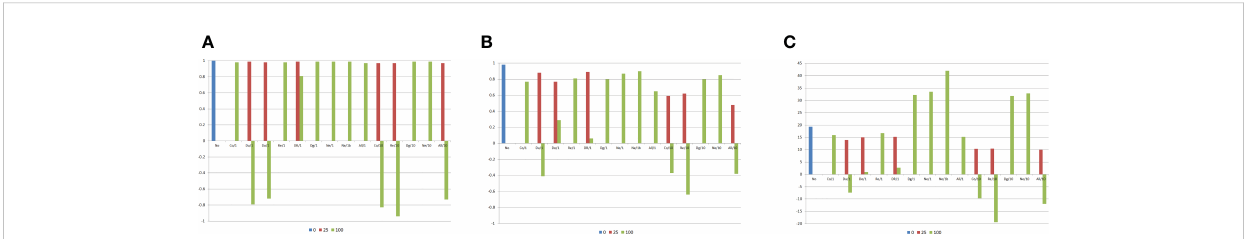
FIGURE 3 Correlations between the average frequency for the genes that increase the trait expression or the average allelic frequency differences between the DH lines and the genetic components of the combining ability analysis, and average heterosis (g/plant), assuming no epistasis (No), seven types of digenic epistasis and an admixture of these types (All), 25% and 100% of epistatic genes, ratio V(I)/(V(A) + V(D)) of 1 and 10, and 20 DHs by population. (A) g * j , (B) s * jj 0 , and (C) H *. b = no dominance.